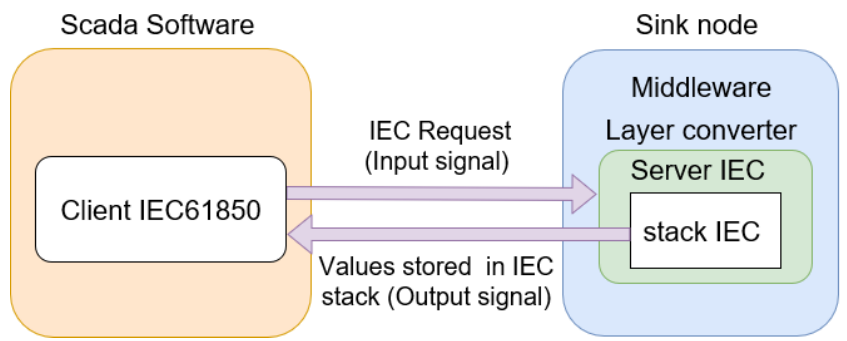
Figure 11. Inputs and outputs related to the